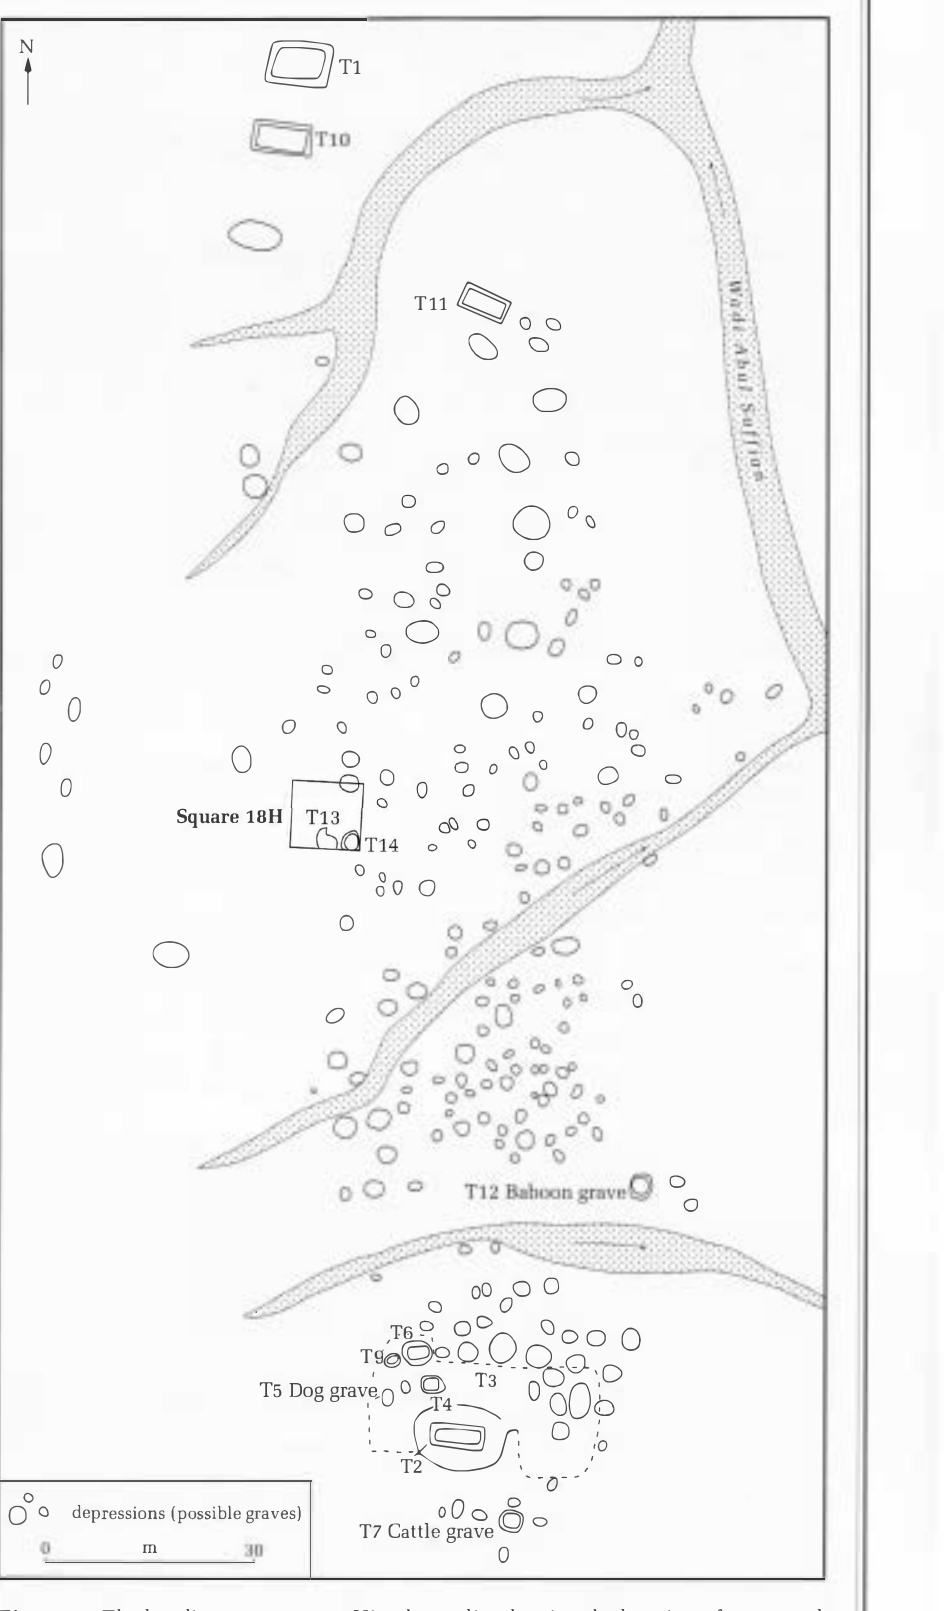
Figure 3 The locality 6 cemetery at Hierakonpolis, showing the location of excavated animal graves and square 18H, where the elephant burial was discovered in tomb